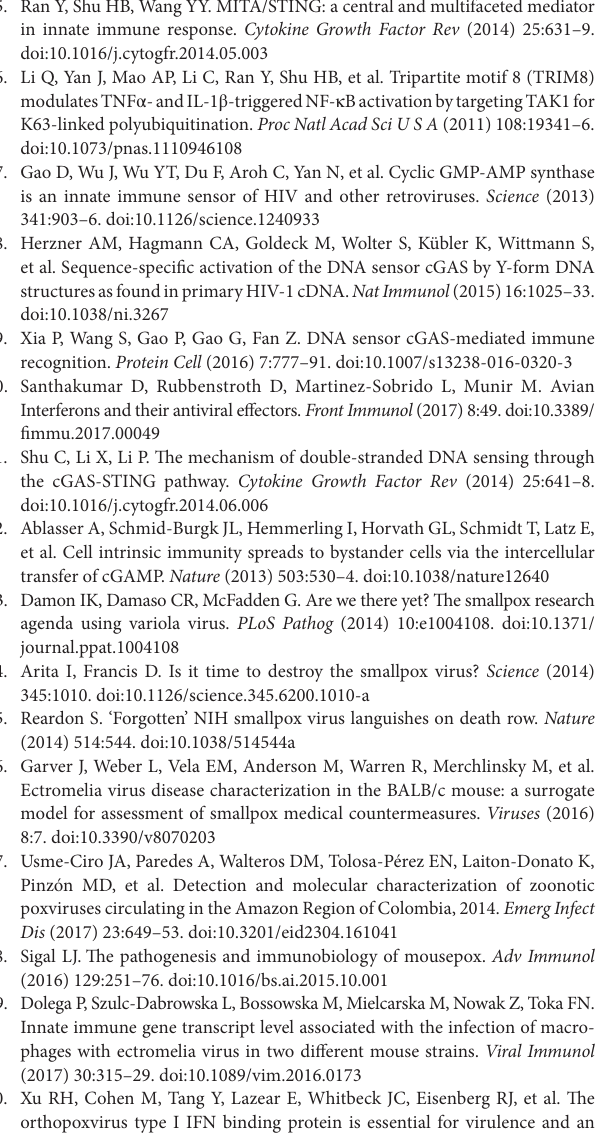
FigUre s3 | Ectromelia virus (ECTV) infection induces the phosphorylation of Tbk1 and Irf3 in L929 cells and RAW264.7 cells, but not in NIH3T3 cells.